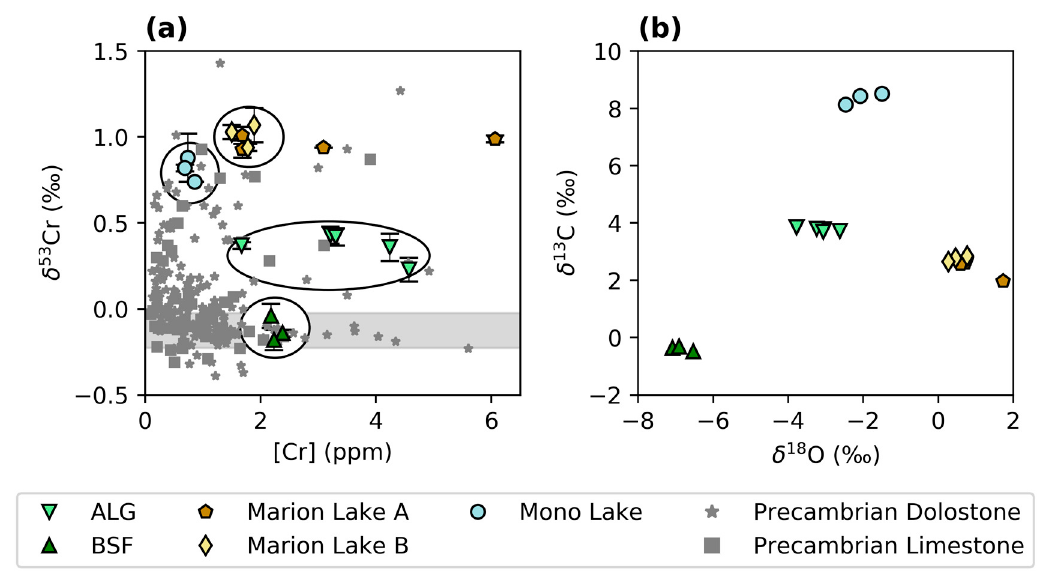
Figure 5. ( a ) Cr as a function of δ 53 Cr values with circles highlighting site-specific δ 53 Cr values, and grey horizontal area representing δ 53 Cr values of detrital material [53]. Literature values of dolostones and limestones from the Precambrian are published in [67–69]. ( b ) Stable C and O isotope ratios, illustrating the differences in the depositional environments and/or the degree of diagenetic overprinting.